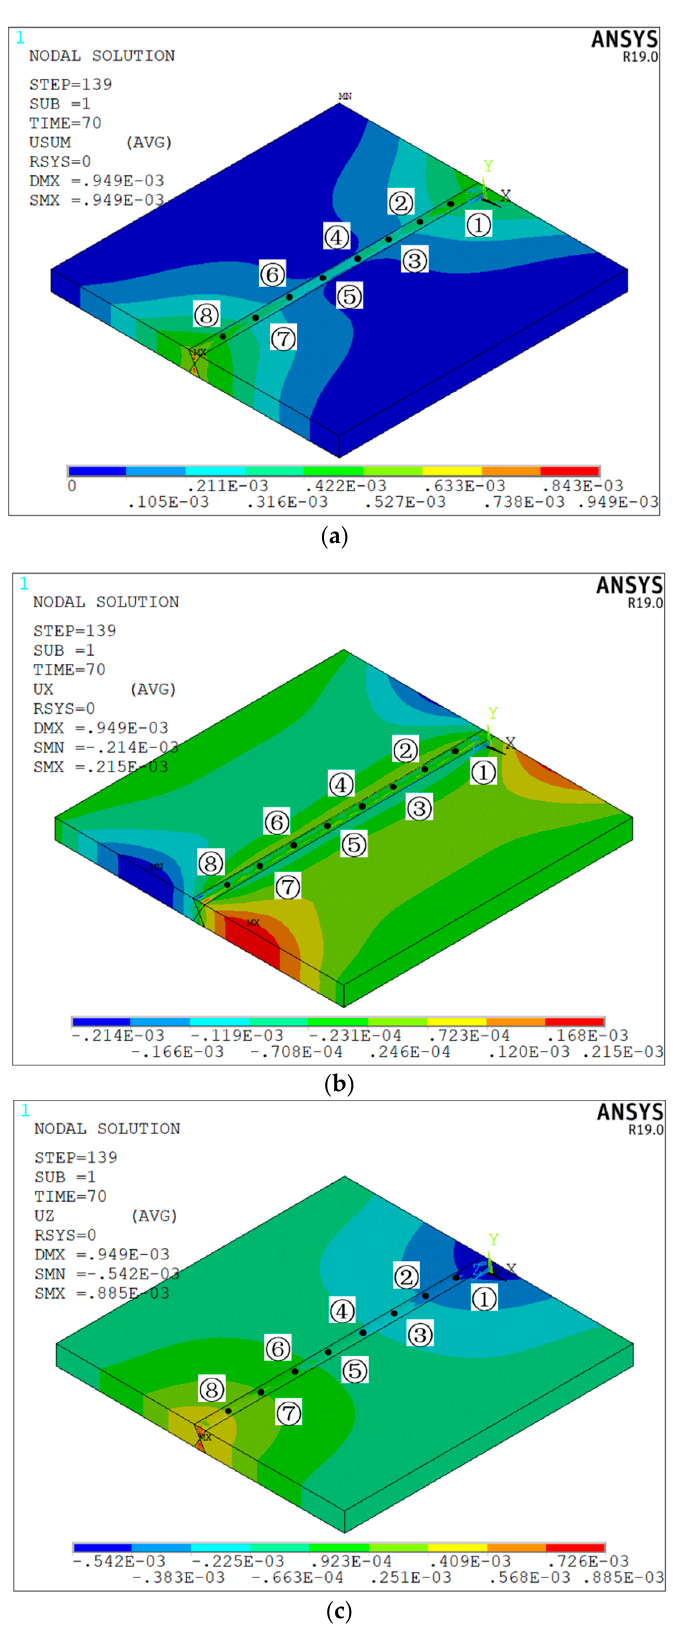
Figure 8. Deformation of welded structure 1 under the welding sequence of " ④⑤③⑥②⑦①⑧ ": ( a ) total deformation cloud map; ( b ) deformation cloud map along the x -axis; ( c ) deformation cloud map along the z -axis.